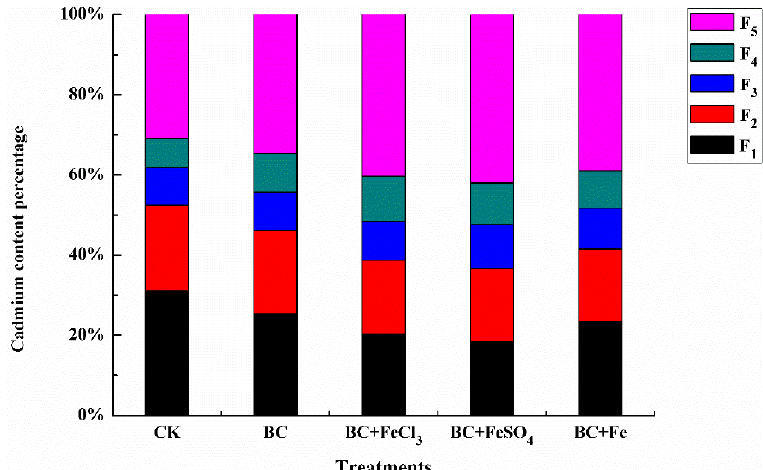
Figure 1. The effect of different treatments on chemical form of Cd in soil.